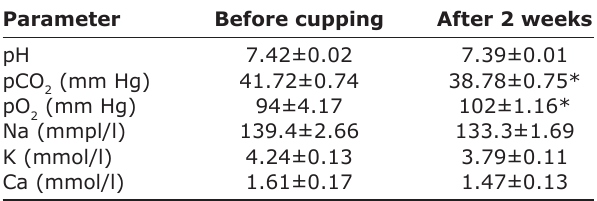
Table-4: Mean±SEM of blood gases and minerals analysis in horses before and after cupping. Parameter